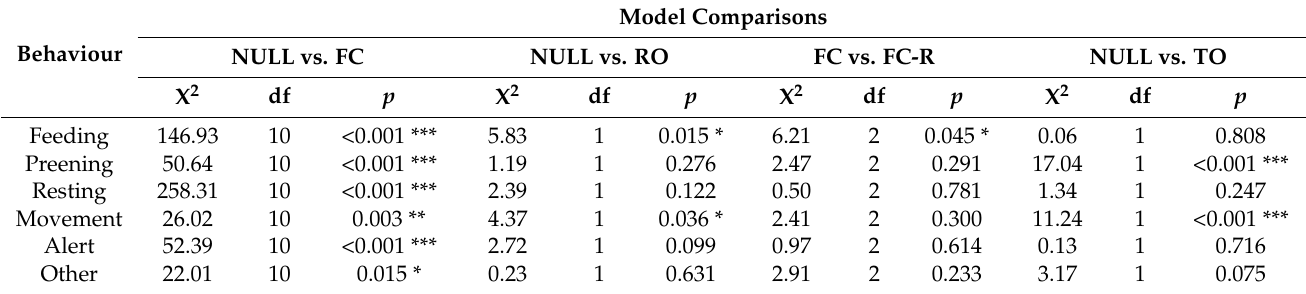
Table 2. Comparison of model performance between binomial GLMMs predicting performance of key state behaviours.